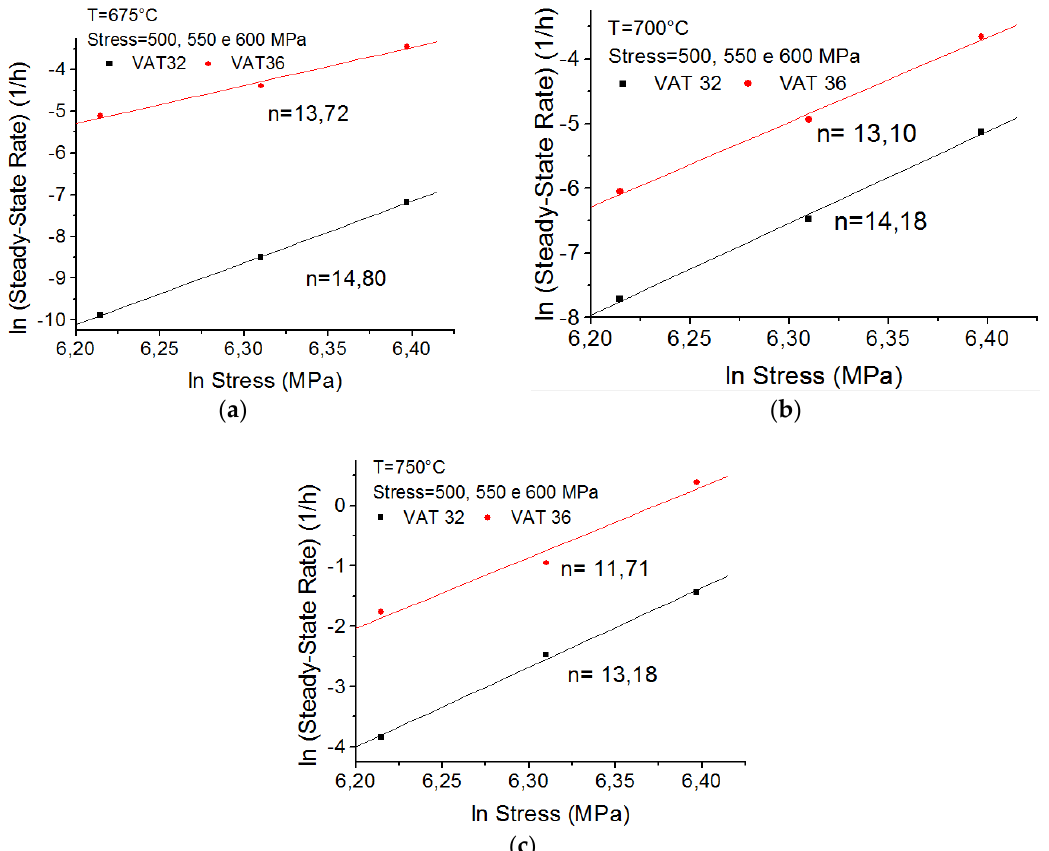
Figure 11. Dependence of the steady-state creep rate with the applied stress to the alloys VAT 32 and VAT 36 at: ( a ) 675 °C. ( b ) 700 °C and ( c ) 750 °C.